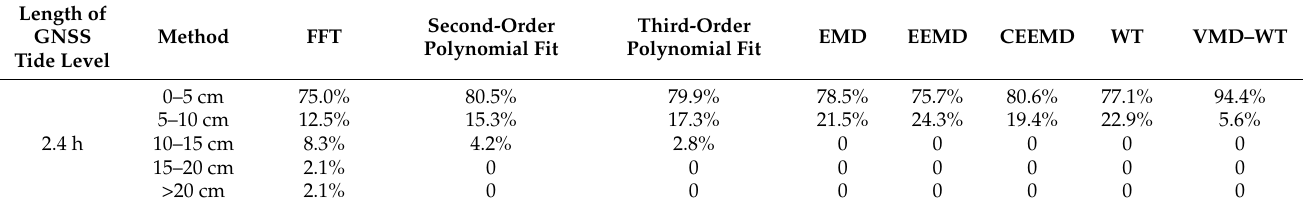
Table 6. Extraction error distribution of the eight filtering methods for 2.4